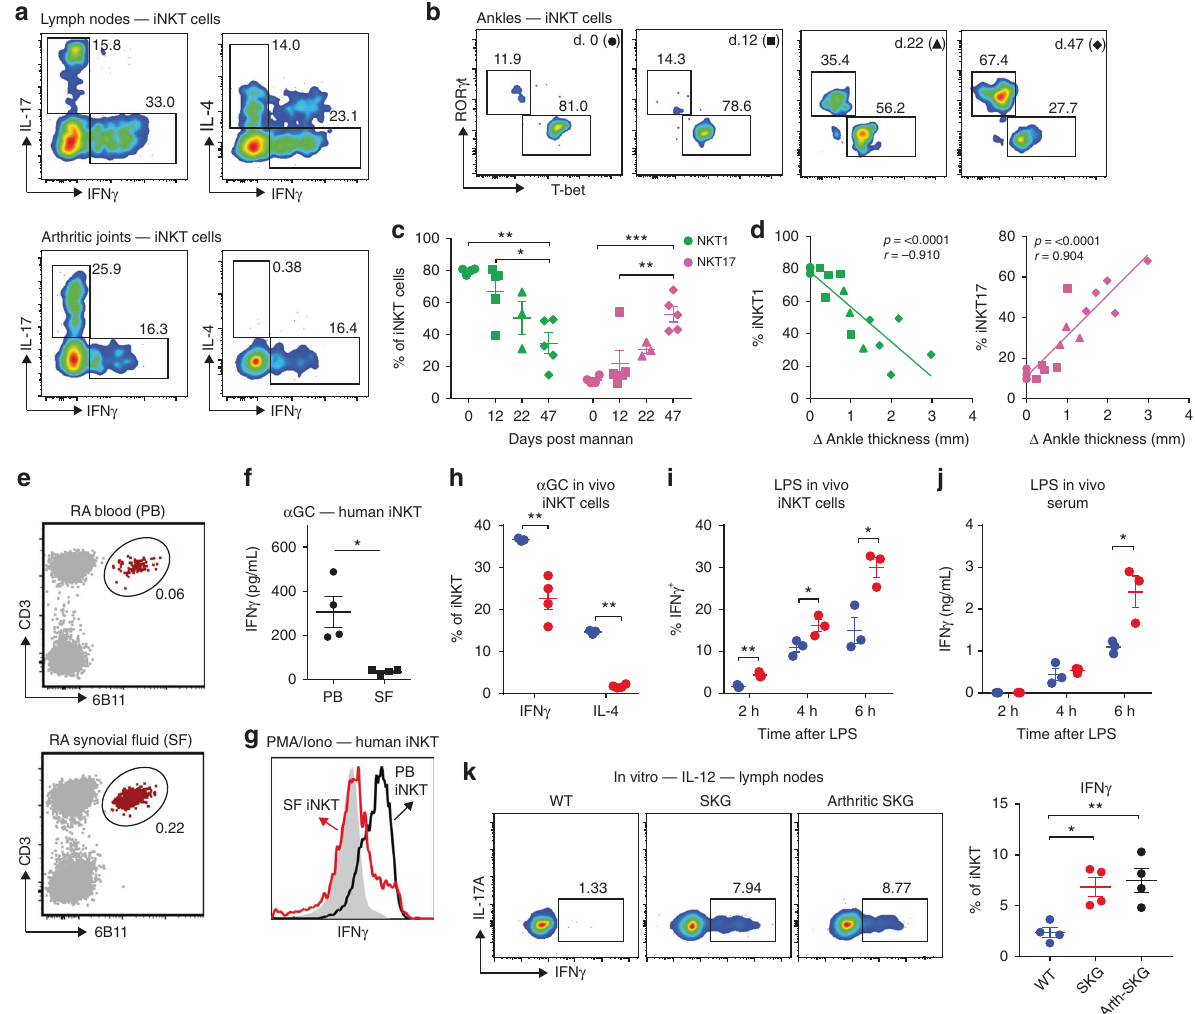
Fig. 6 NKT1 cells negatively correlate with arthritis severity in SKG mice. a Representative fl ow cytometry plot of cytokine pro fi le of iNKT (TCR β int CD1d-